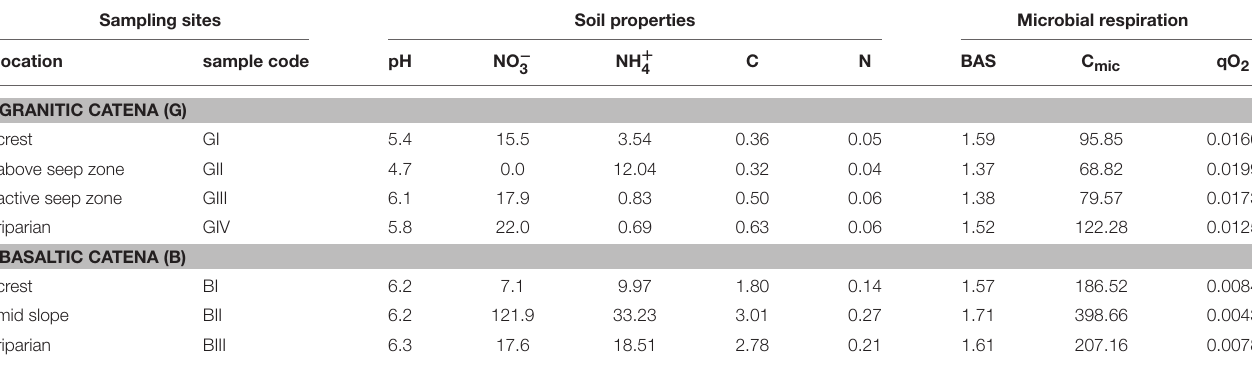
TABLE 1 | Geochemical soil properties and microbial respiration